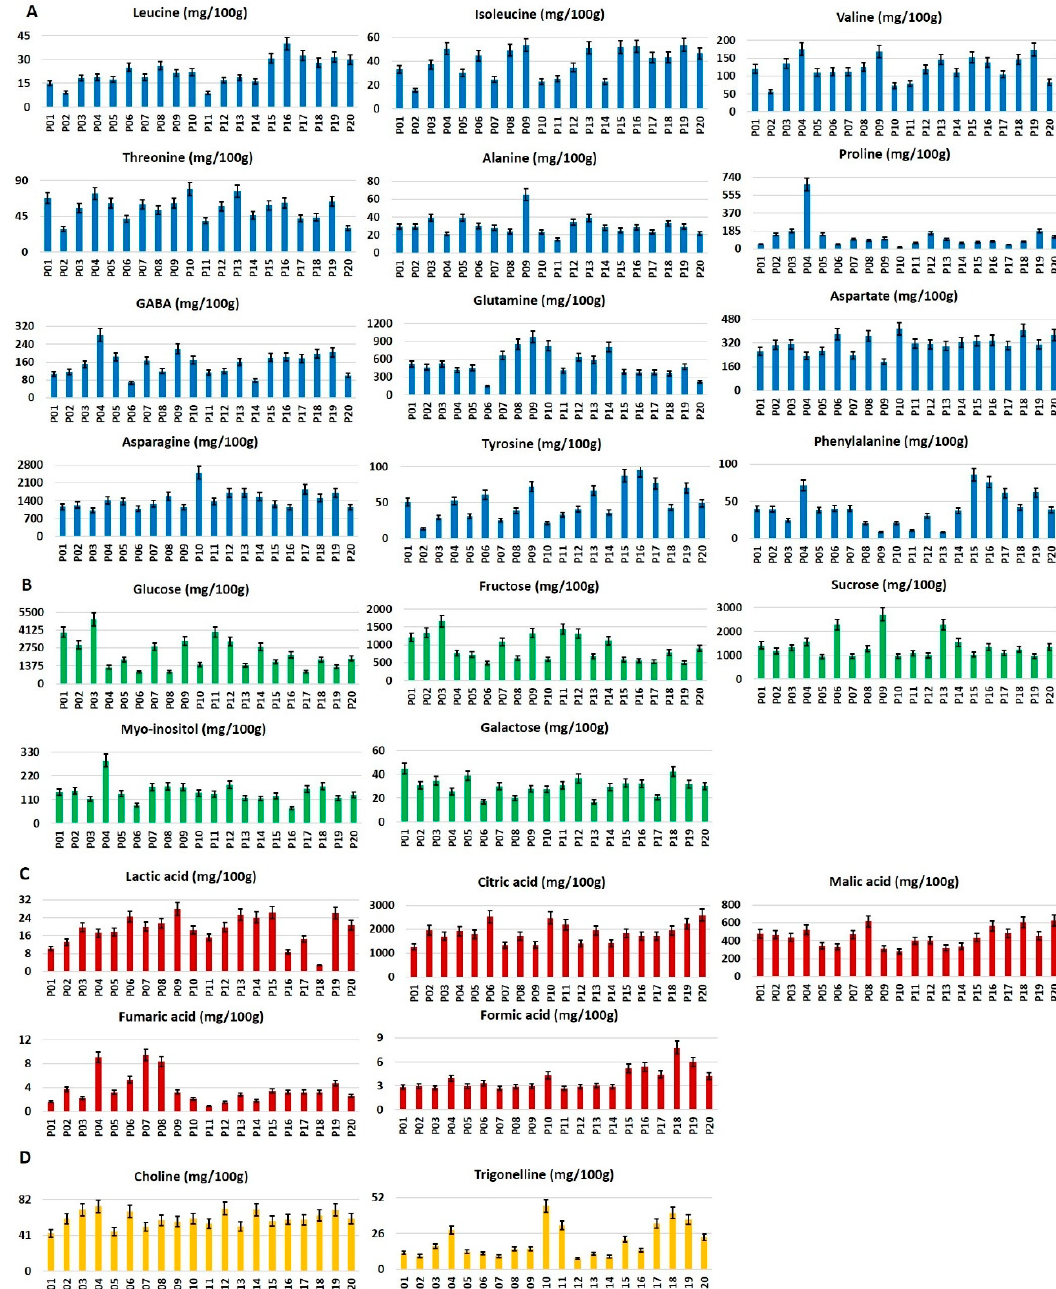
Figure 2. Histograms relative to metabolites (mg / 100 g dry weight ± standard deviation SD) identified and quantified in NMR (Nuclear Magnetic Resonance) spectra of potato cultivars hydroalcoholic Bligh–Dyer extracts: ( A ) amino acids, ( B ) sugars, ( C ) organic acids, ( D ) other metabolites. Servane (P01), Piatlina (P02), Jelly (P03), Ratte (P04), Bintje (P05), Agria (P06) and Malou (P07), Rouge des